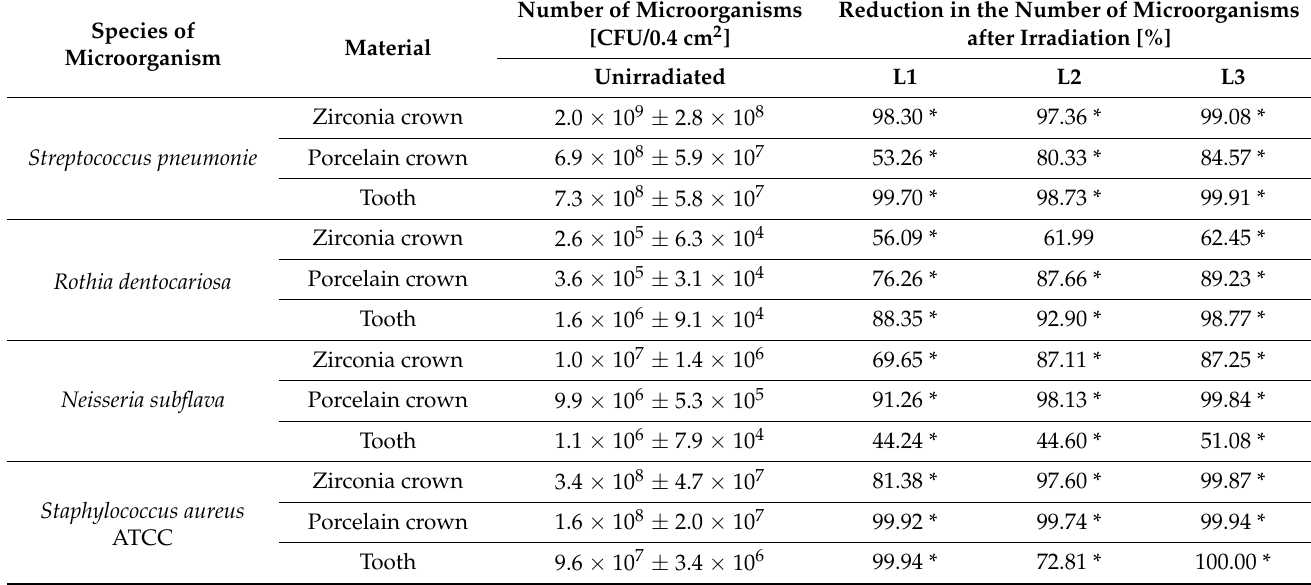
Table 4. The results of the effectiveness of laser irradiation against the most common microorganisms on the porcelain crowns, zirconia crowns as well as teeth before and after irradiation with various laser dose. Species of